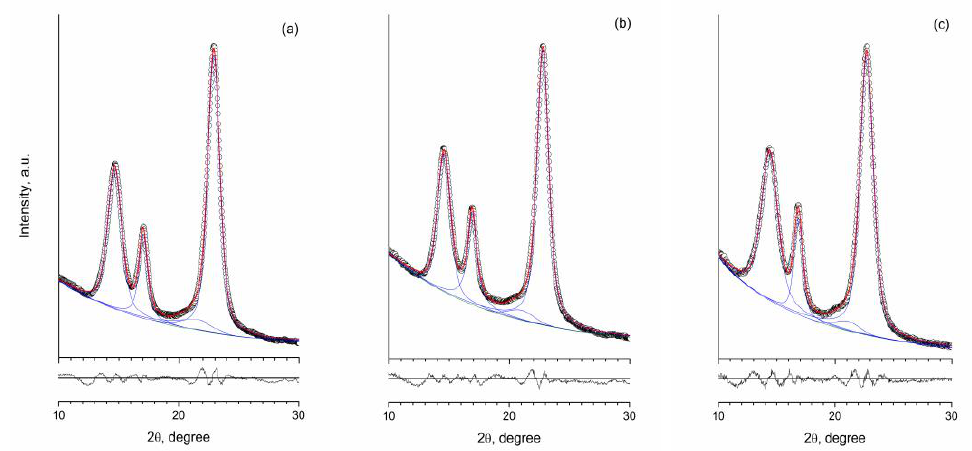
Figure 3. Deconvolution of the diffraction patterns of bacterial cellulose samples to pseudo-Voigt functions. ( a ) an initial sample; ( b ) a sample treated by CBHSc for 4 h; ( c ) a sample treated for 24 h (circles are experimental data, green line is the baseline, red line is the deconvolution, blue line is peak fitting to pseudo-Voigt functions, black line is the difference curve).